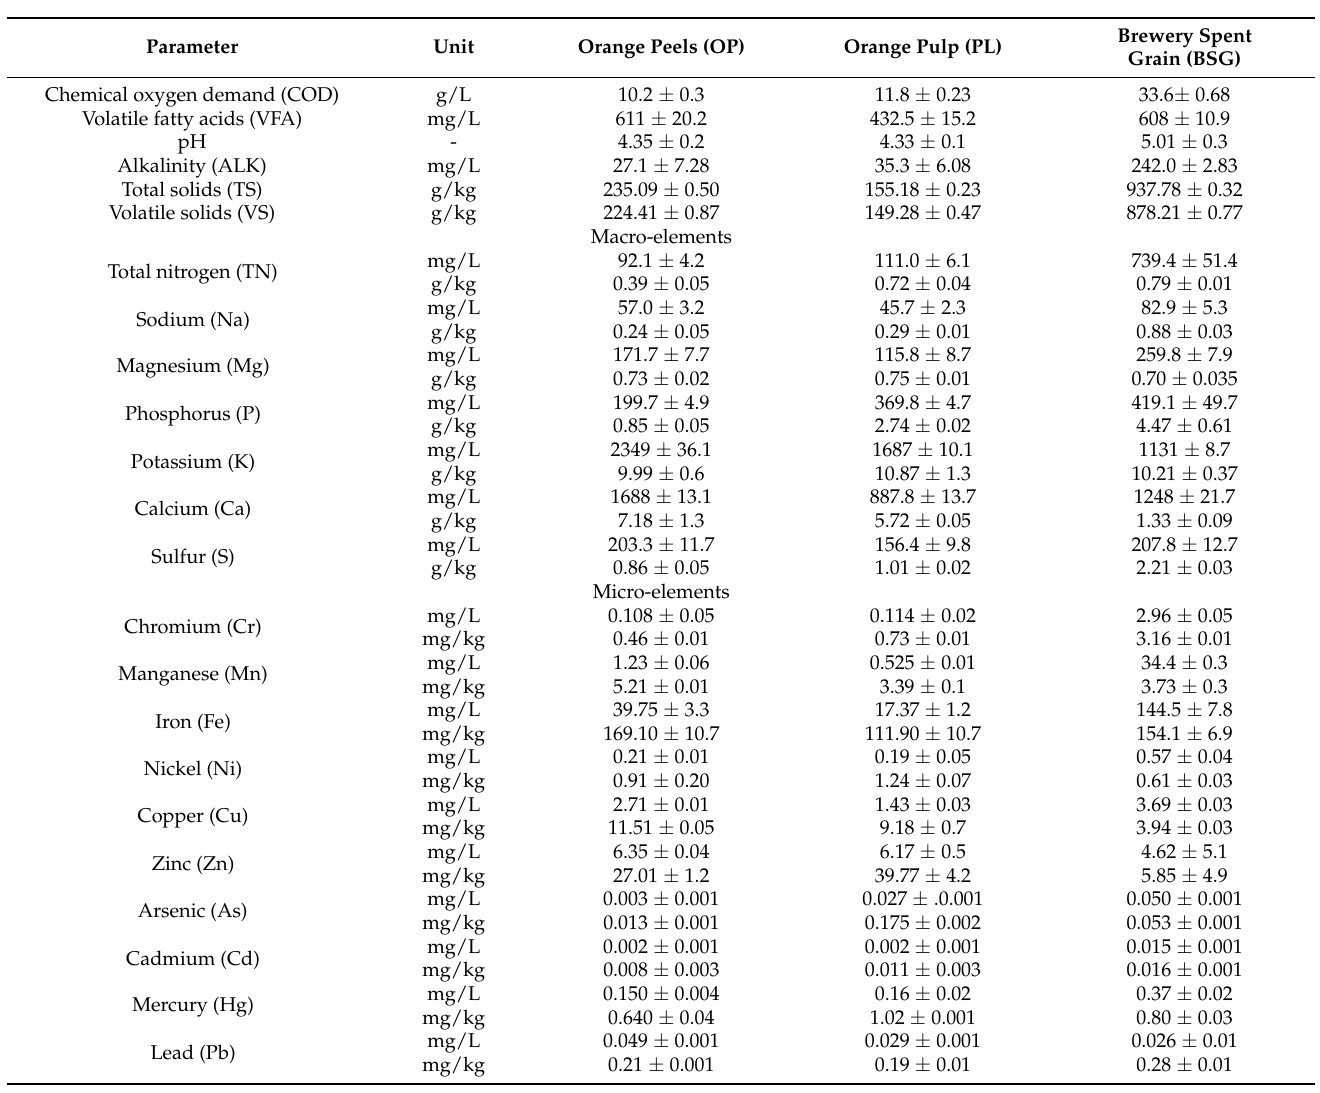
Table 1. Composition of the co-substrates used in the experiment (average values and standard deviations are